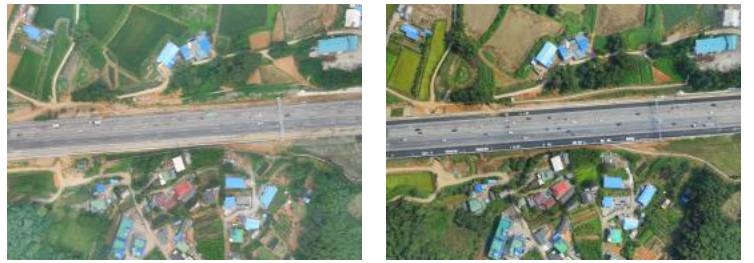
Figure 5. Orthoimages of some areas using ( left ) the first flight data and ( right ) third flight data.